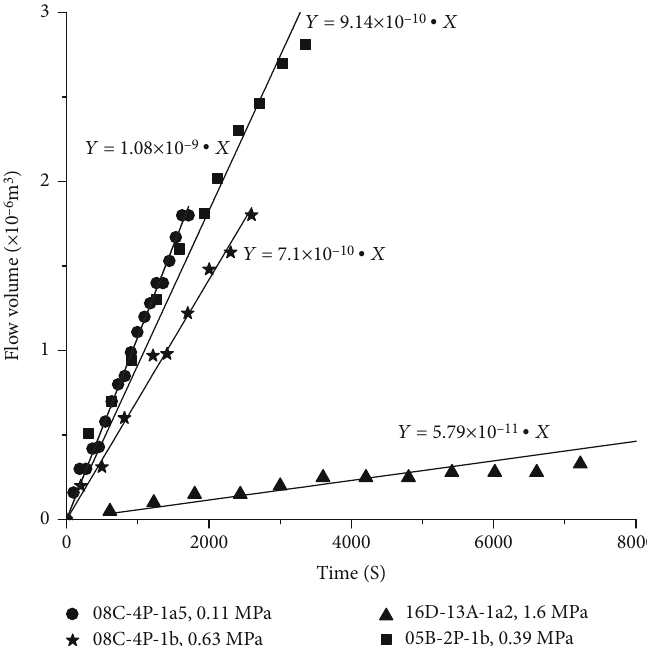
Figure 4: Flow volume versus time for the permeability tests.